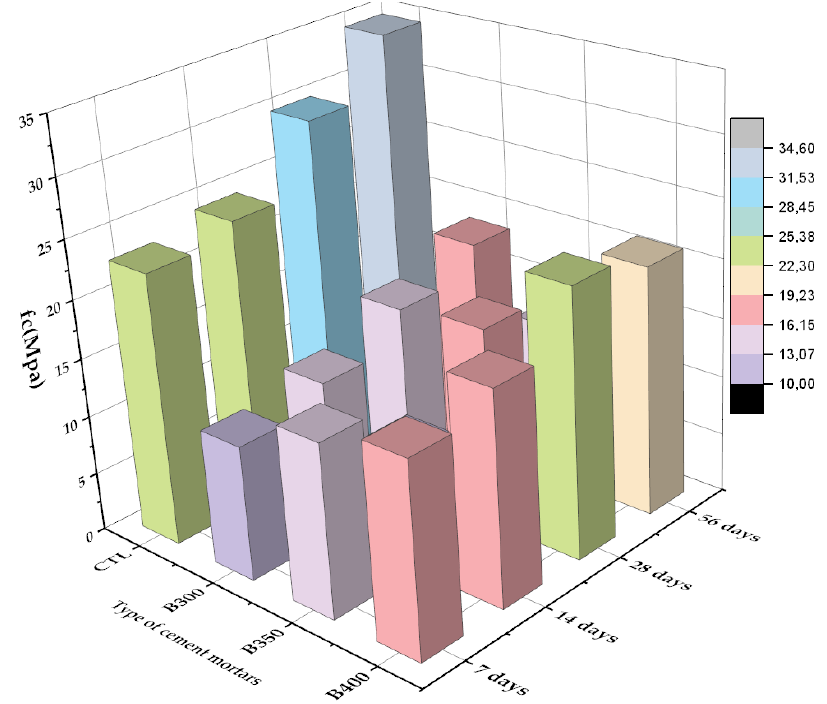
Figure 4. Compression test results for specimens with a partial replacement of cement with biochars produced at temperatures of 300, 350, and 400 °C.